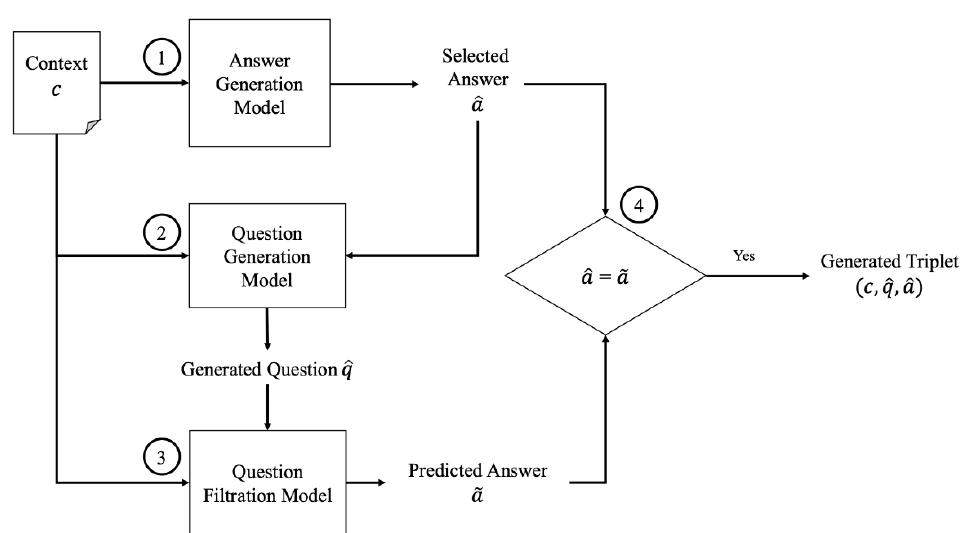
Figure 7. Illustration of the Question Generation pipeline.